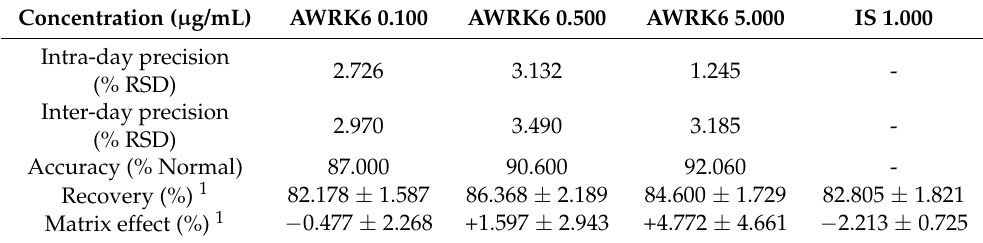
Figure 2. Chromatograms of blank plasma ( A ), spiked blank plasma ( B ), and a sample obtained at 30 min after intraperitoneal administration with AWRK6 at 4.7 mg/kg bodyweight ( C ). Table 1. Method validation for precision, accuracy, recovery, and matrix effect.